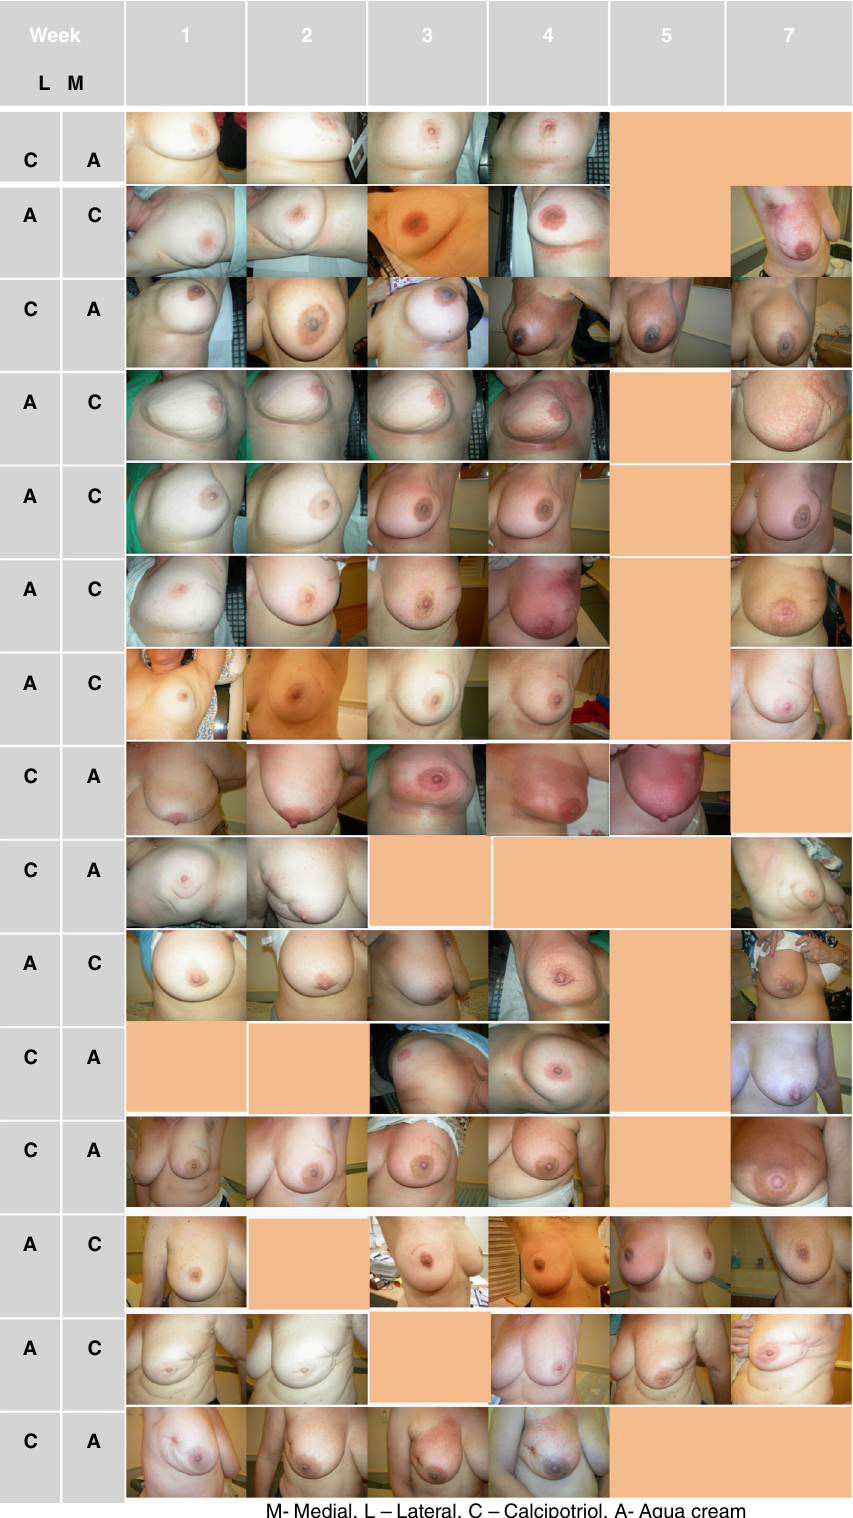
Fig. 2 Breast skin reaction during radiation therapy. The irradiated breast was photographed each week, and at each follow-up visit. Each raw refers to the same patient. Lateral (L) or medial (M) parts of the irradiated breast were treated with Calcipotriol (C) or Aqua cream